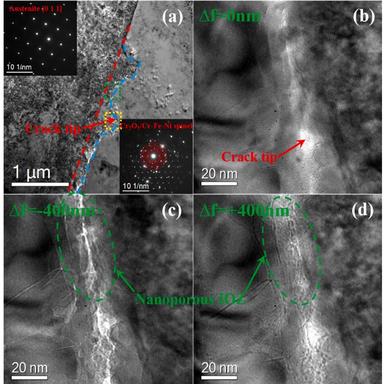
(a) DFTEM image showing DIGM around the crack tip of Alloy 60Ni tested at 360 ◦C; Fresnel contrast TEM (b) in-focused, (c) under-focused, and (d) overfocused images showing the nanoporous IOZ.